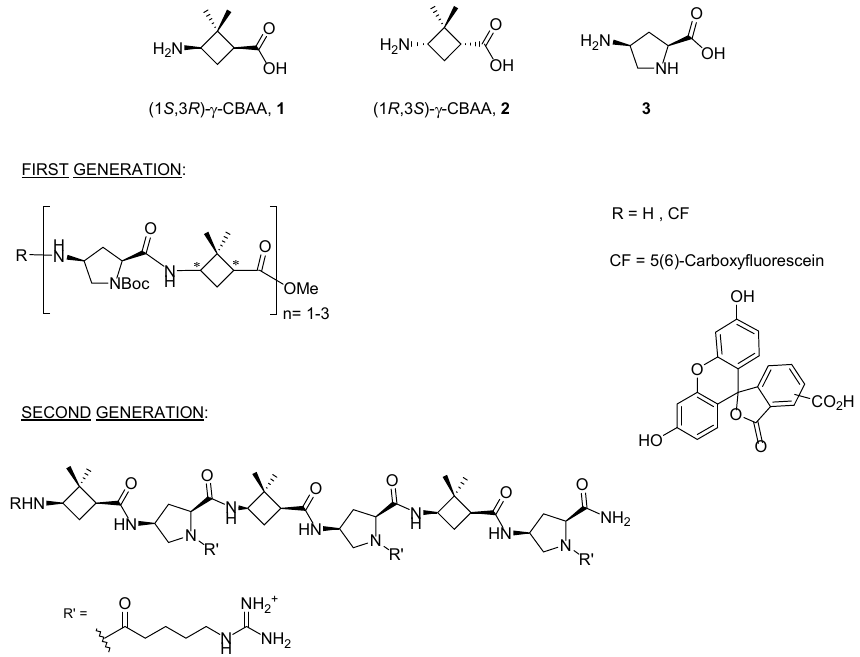
Figure 1. Monomers used in the first and second generations of hybrid cyclobutane / proline γ / γ -peptides labelled with 5(6)-carboxyfluorescein (CF).